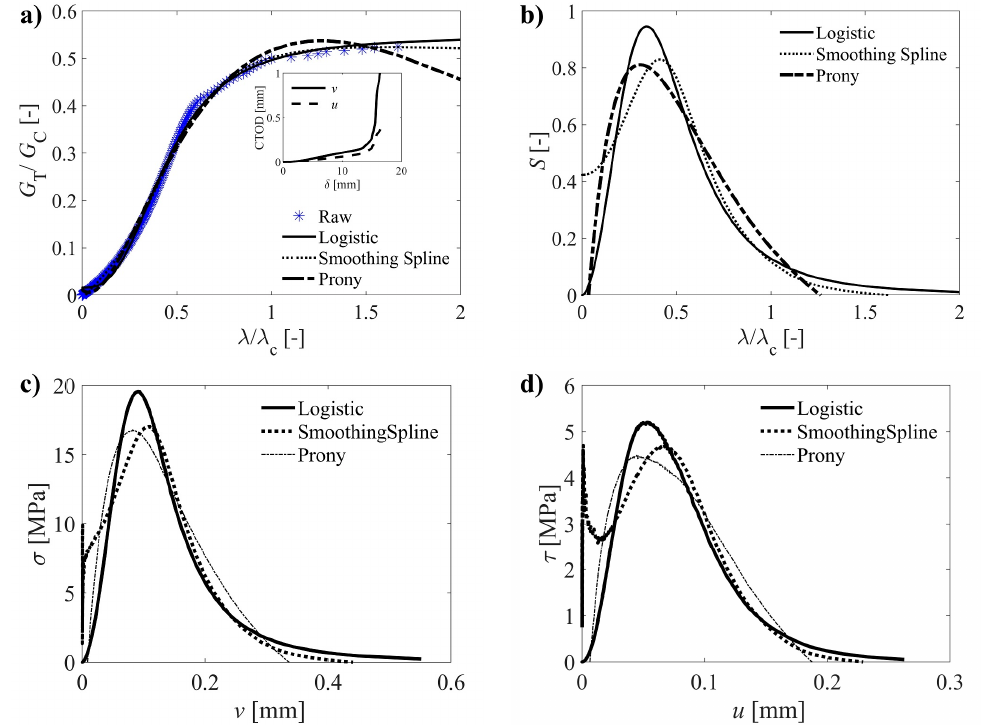
Figure 5. For a typical specimen: ( a ) potential function; ( b ) normalized cohesive law; ( c ) mode I; and ( d ) mode II components of the reconstructed cohesive laws.